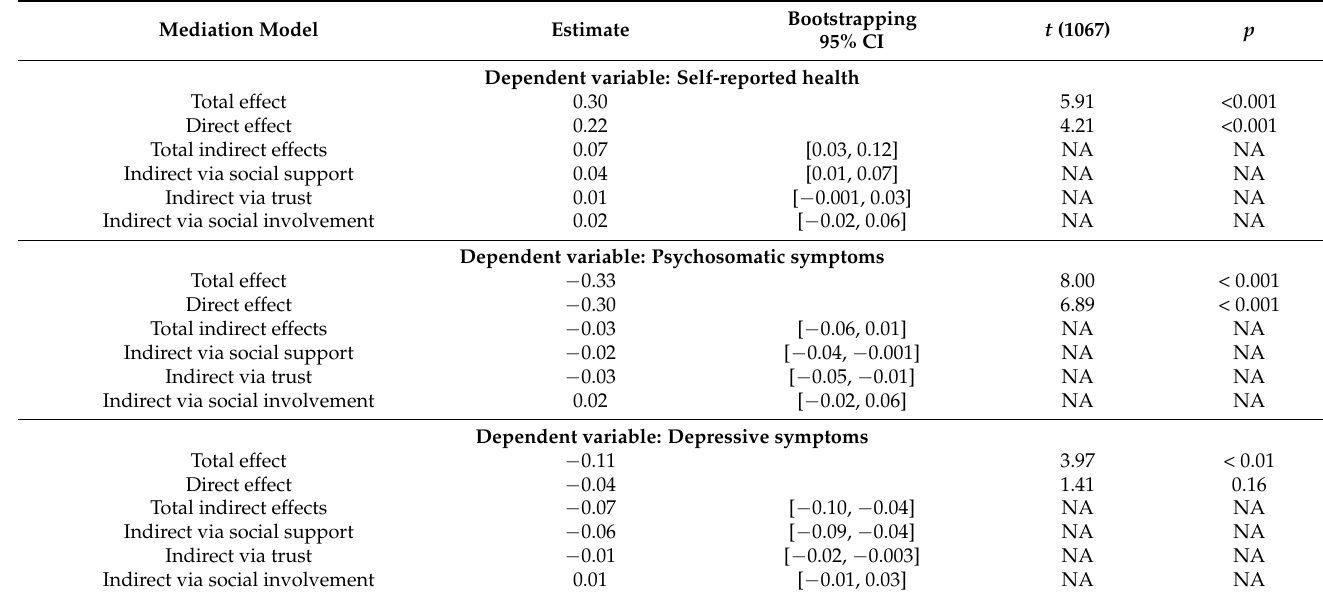
Table 4. Direct and indirect unstandardized effects on health components with social capital variables as mediators. Mediation